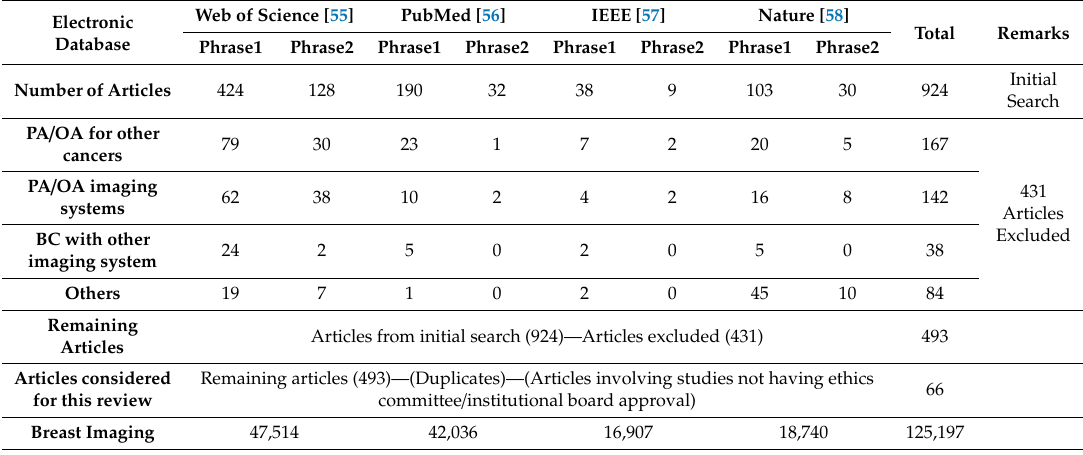
Table 2. Literature search